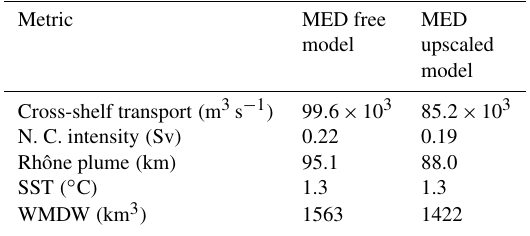
Table 1. Root mean square difference between parent and child model for the case of the free parent model and the upscaled parent model for the defined